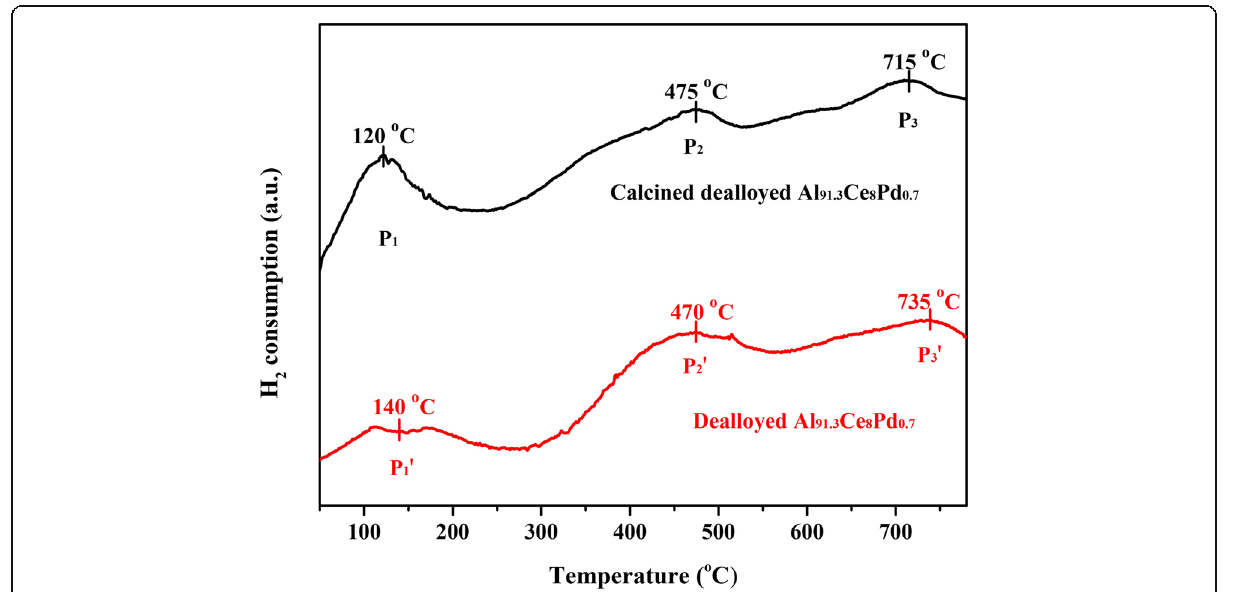
Fig. 7 H 2 -TPR curves of the dealloyed Al 91.3 Ce 8 Pd 0.7 ribbons and the dealloyed Al 91.3 Ce 8 Pd 0.7 ribbons calcined at 400